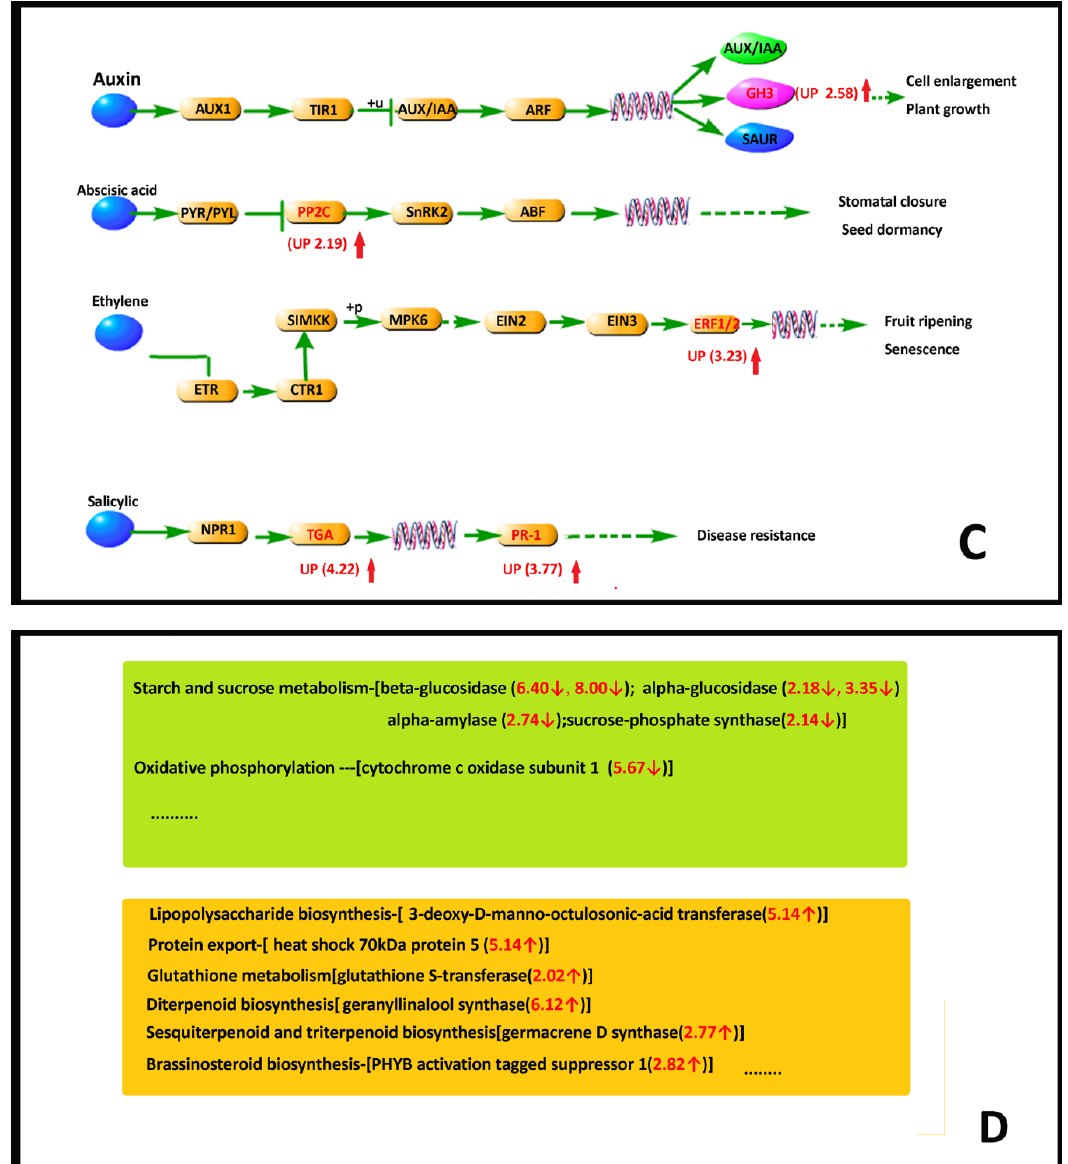
Figure 8. Pathway of differentially expressed genes. ( A )The pathway of flavonoids biosynthesis; ( B ) The pathway of carbon fixation in photosynthetic organisms; ( C ) The pathway of plant hormone signal transduction; ( D ) The pathway of other DEGs pathway.